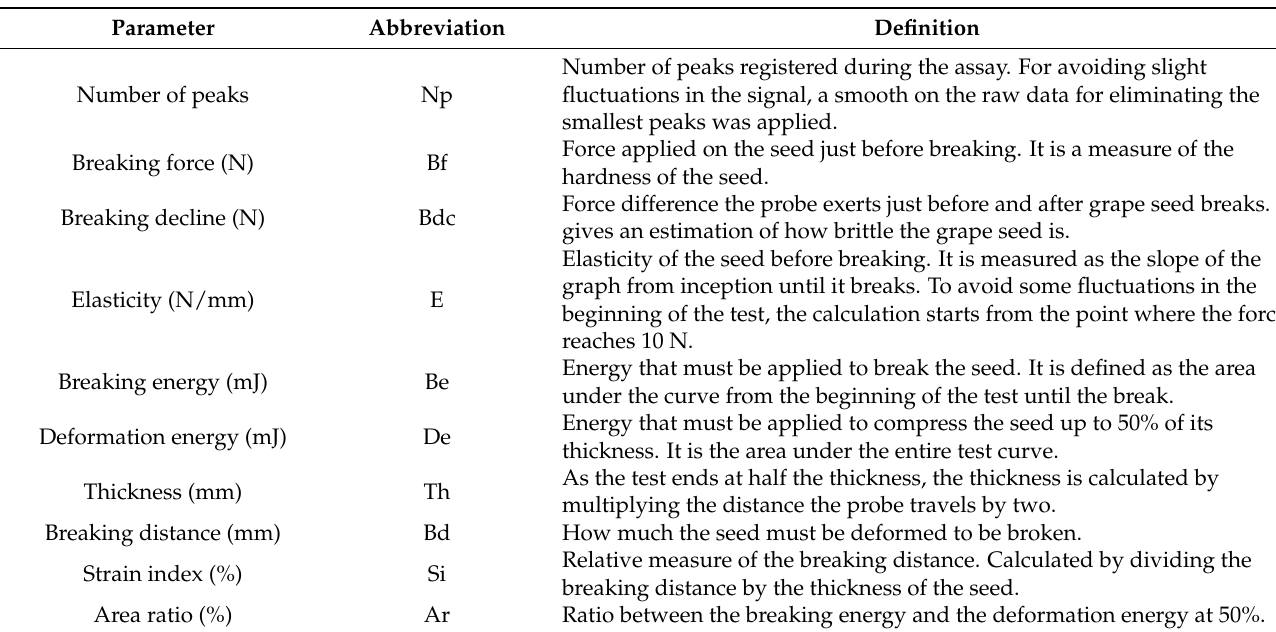
Figure 1. Force–distance curves and the extracted parameters of grape seeds. Np, number of peaks; Bf, breaking force; Bdc, breaking decline; E, elasticity; Be, breaking energy; De, deformation energy; Th, thickness; Bd, breaking distance; Si, strain index. Table 1. Parameters extracted from force–distance curve of the texturometer.